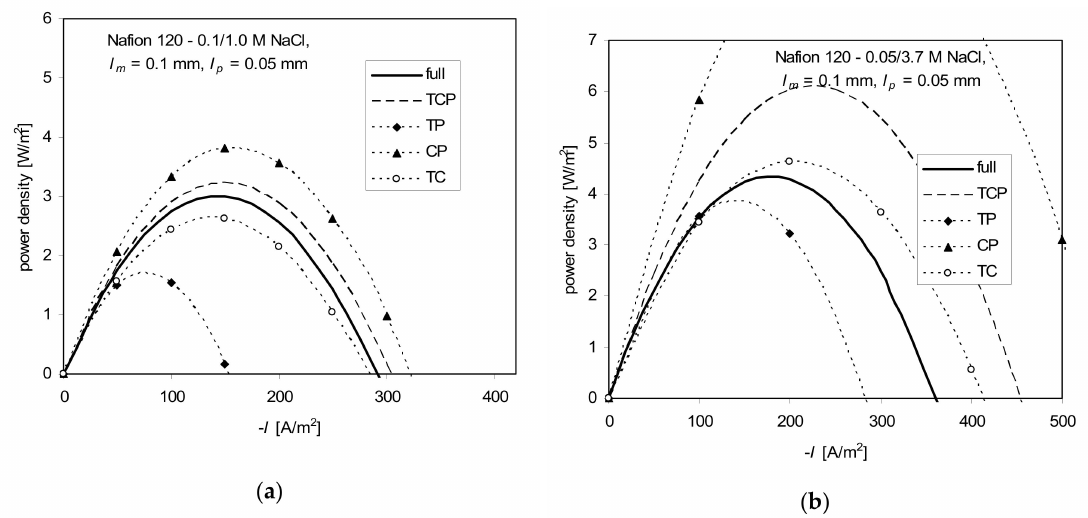
Figure 7. Power density vs. current density for full model and approximate approaches: TCP—3-coe ffi cients approach (P 1 , P 2 , and L12 calculated from t 1, app , k m , and P s ), (t 1 app , P s );